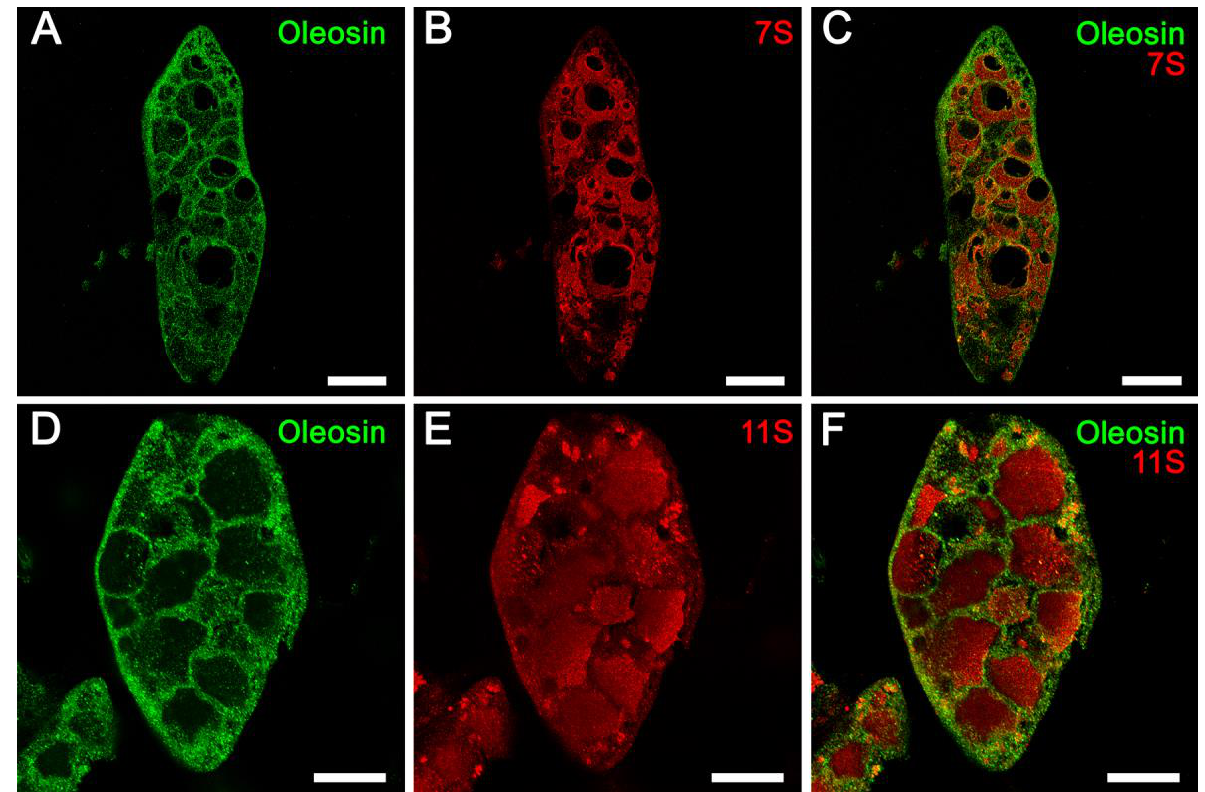
Figure 4. Fluorescence immunolabeling of oleosin, 7S and 11S globulins. Specific binding of the antibodies was detected by incubating the sections with either Alexa Fluor 488 labeled goat anti-chicken IgY antibodies (oleosin) or with Alexa Fluor 594 labeled goat anti-rabbit IgG antibodies (7s or 11S). PSV = protein storage vacuole, LB = lipid body. Scale bars for ( A – C ) are 20 µm. Scale bars for ( D – F ) are 10 µm.